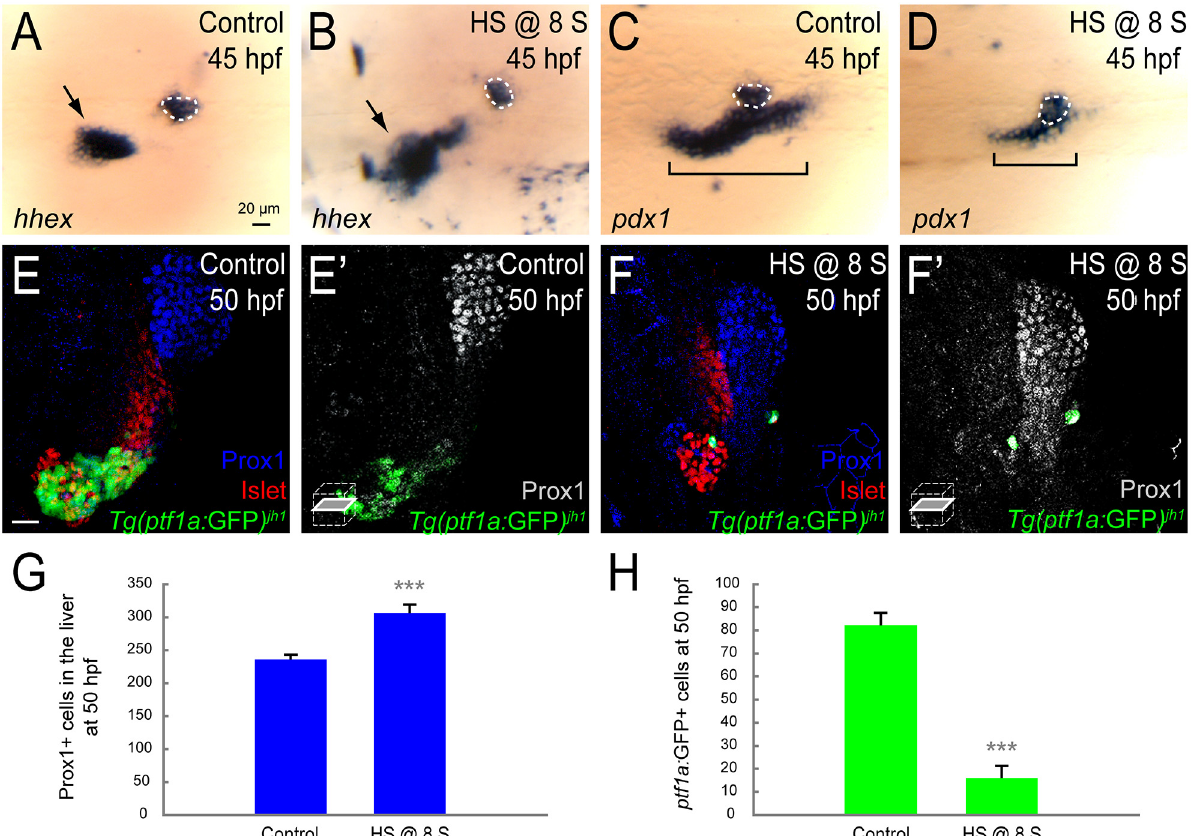
Fig 4. Increased Fhl1b activity suppresses specification of pancreatic cells and induces liver. (A-D) Whole-mount in situ hybridization showing the expression of hhex (A and B) and pdx1 (C and D), comparing control embryos (A and C) and fhl1b- overexpressing embryos (B and D, heat shock applied at the 8-somite stage) at 45 hpf. hhex is expressed in the liver (black arrows) and the dorsal pancreatic bud (white dotted circles). pdx1 is expressed in the developing pancreas including the dorsal pancreatic bud (white dotted circles) and intestine (black brackets), but not in the liver. When fhl1b expression was induced at the 8-somite stage, hhex expression was greatly expanded in the liver (B, black arrow), while pdx1 expression in the developing gut was reduced (D, black bracket). hhex and pdx1 expression in the dorsal pancreatic bud in fhl1b -overexpressing embryos was comparable to that of control embryos. (E-F ’ ) Confocal images showing Islet (red), Prox1 (blue in E and F; grey in E ’ and F ’ ), and Tg(ptf1a :GFP ) jh1 (green) expression at 50 hpf, comparing control embryos (E and E ’ ) and fhl1b -overexpressing embryos (F and F ’ , heat shock applied at the 8-somite stage). When fhl1b expression was induced at the 8-somite stage (F and F ’ ), the Prox1 expression domain was expanded, whereas Tg(ptf1a :GFP ) jh1 expression was drastically reduced. (G) Quantification of the number (mean ± SD) of Prox1-positive cells in the liver at 50 hpf. 235.5 ± 7.3 cells were Prox1-positive in control embryos, while 306.5 ± 12.6 cells were Prox1-positive in fhl1b -overexpressing embryos (heat shock applied at the 8-somite stage). Cells in 20 planes of confocal images from 5 individual embryos were counted. Asterisks indicate statistical significance: *** , P < 0.001. (H) Quantification of the number (mean ± SD) of Tg(ptf1a :GFP ) jh1 -expressing cells in the exocrine pancreas at 50 hpf. The number of Tg(ptf1a :GFP ) jh1 -expressing cells decreased from 82.2 ± 6.4 in control embryos to 16.0 ± 5.2 in fhl1b- overexpressing embryos (heat shock applied at the 8-somite stage). Cells in 20 planes of confocal images from 5 individual embryos were counted. Asterisks indicate statistical significance: *** , P < 0.001. A-D, dorsal views, anterior to the left. E and F, confocal projection images; E ’ and F ’ , confocal single-plane images, ventral views, anterior to the top. Scale bars, 20 μ